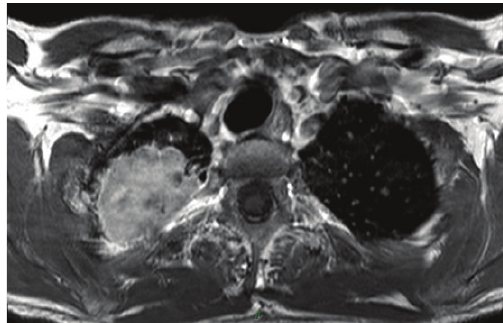
Figure 5: Post-Gadolinium T1W TSE axial image. The intravenous injection of Gadolinium is helpful in the assessment of a vascular invasion and may also help distinguish between posttreatment fibrosis and recurrence of the